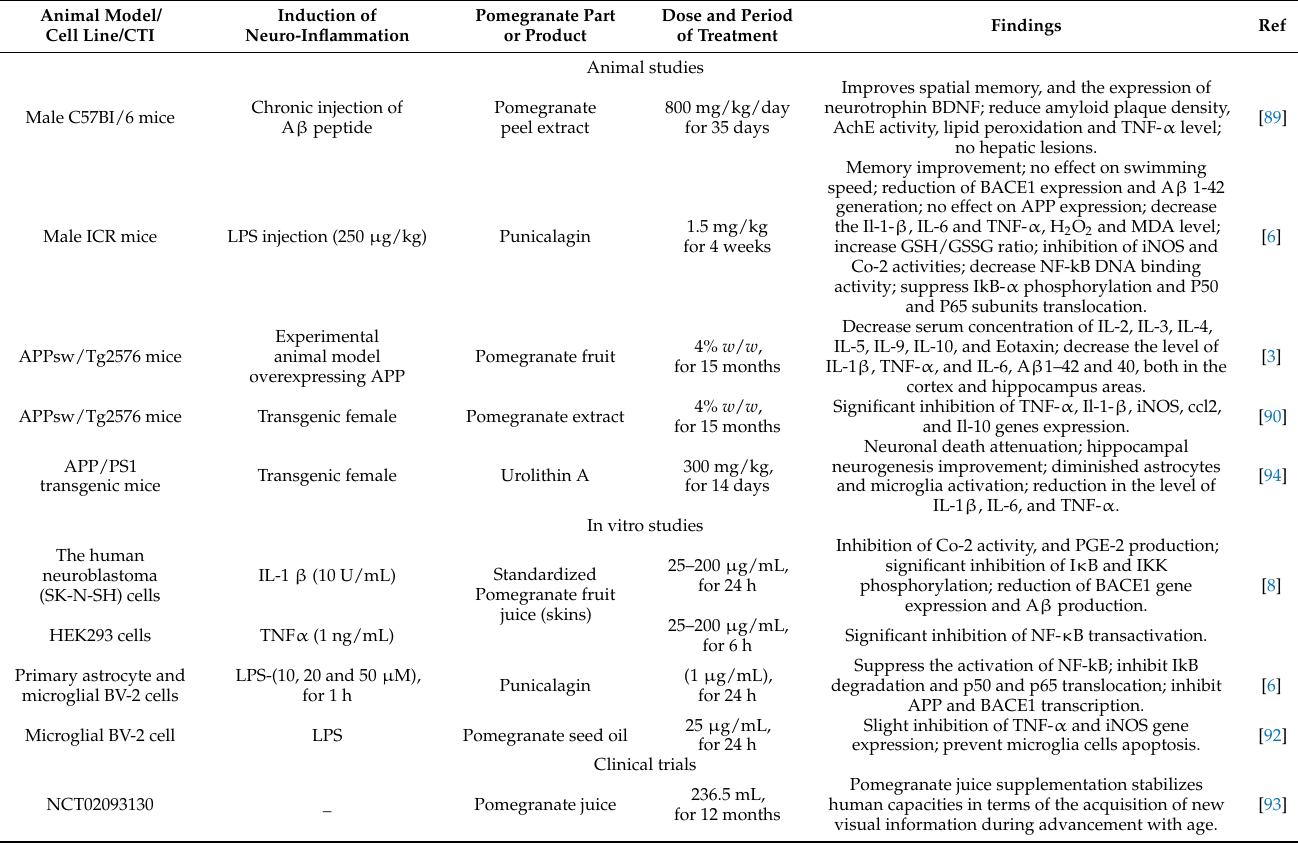
Table 3. Summary of the main in vivo and in vitro findings related to the effect of the pomegranate intake on memory and neuro-inflammation implicated in Alzheimer’s